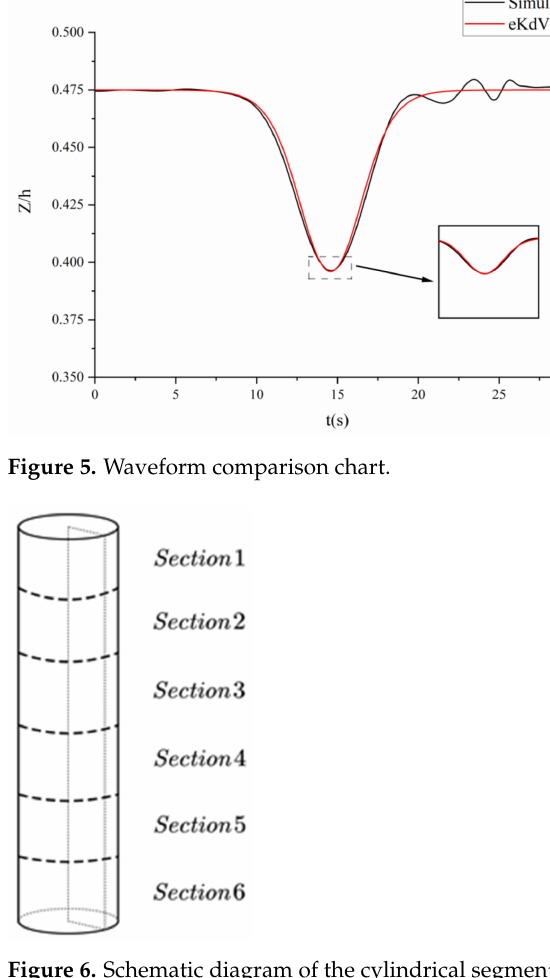
Figure 6. Schematic diagram of the cylindrical segment.